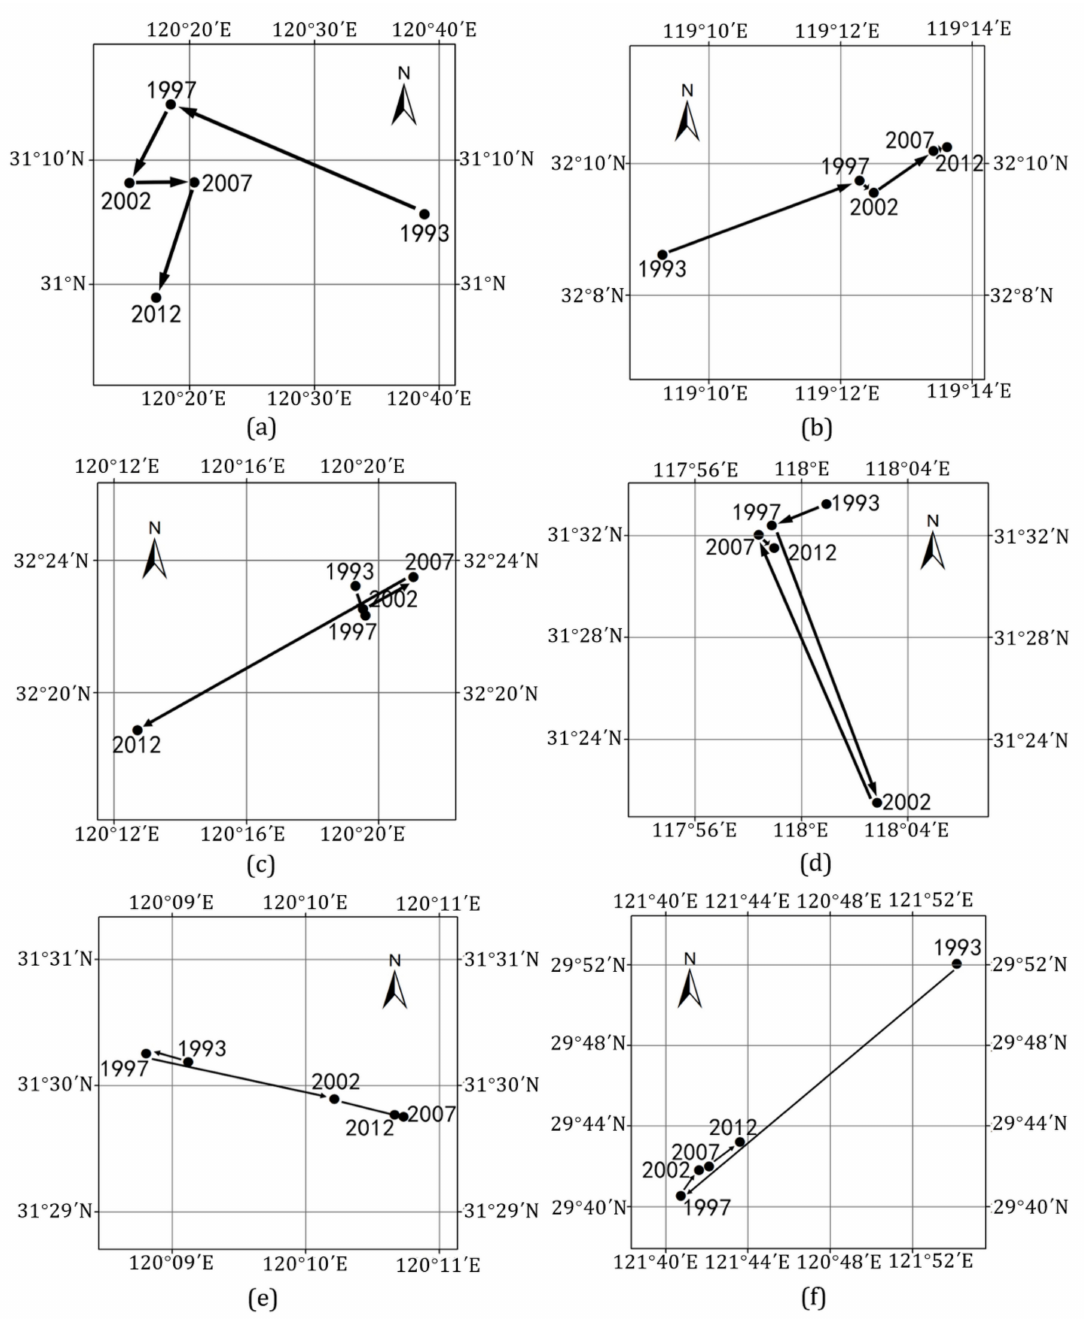
Figure 7. SDE center location changes occurring from 1993 to 2012 for ( a ) The YRDUA; ( b ) Nanjing metropolitan circle; ( c ) Hangzhou metropolitan circle; ( d ) Hefei metropolitan circle; ( e ) Suxichang metropolitan circle; and ( f ) Ningbo metropolitan